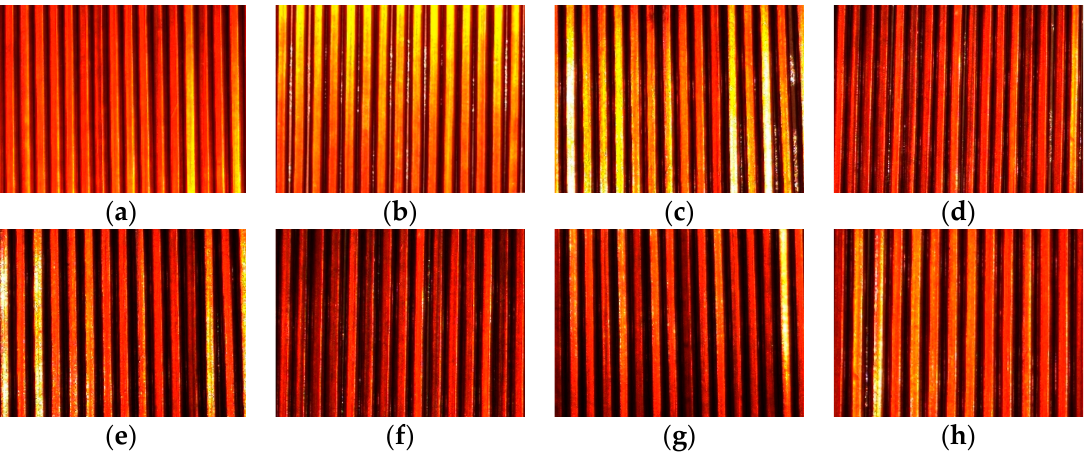
Figure 21. ROI images during production: ( a – d ) is the ROI of the 2.4 mm wire; ( e – h ) is the ROI of the 2.6 mm wire.